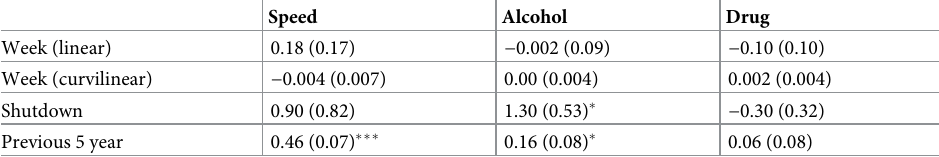
Parameter estimates (B) with standard errors in parentheses are reported. �